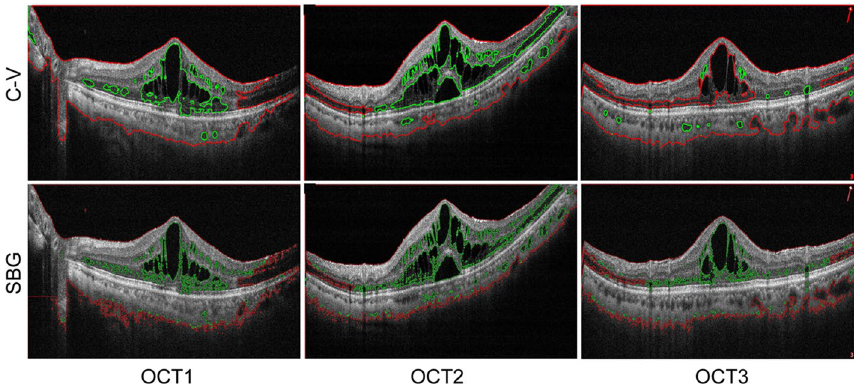
Figure 8. Segmentation results of macular edema by different methods. Red line is the initial contour curve of segmentation; Green line is the segmentation result of macular edema.